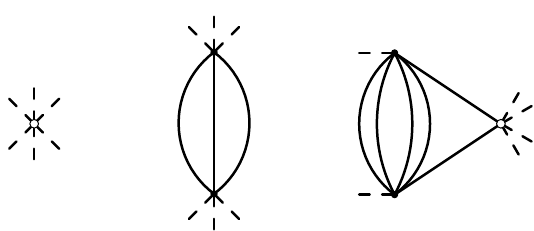
Figure 11. The three diagrams that contribute to the bare expansion of the six-point couplings up to order three (bare coupling, D and S , see section 5.1.1). The black circles represent wheel vertices and the white circles can be any of the I i interactions (including the wheel